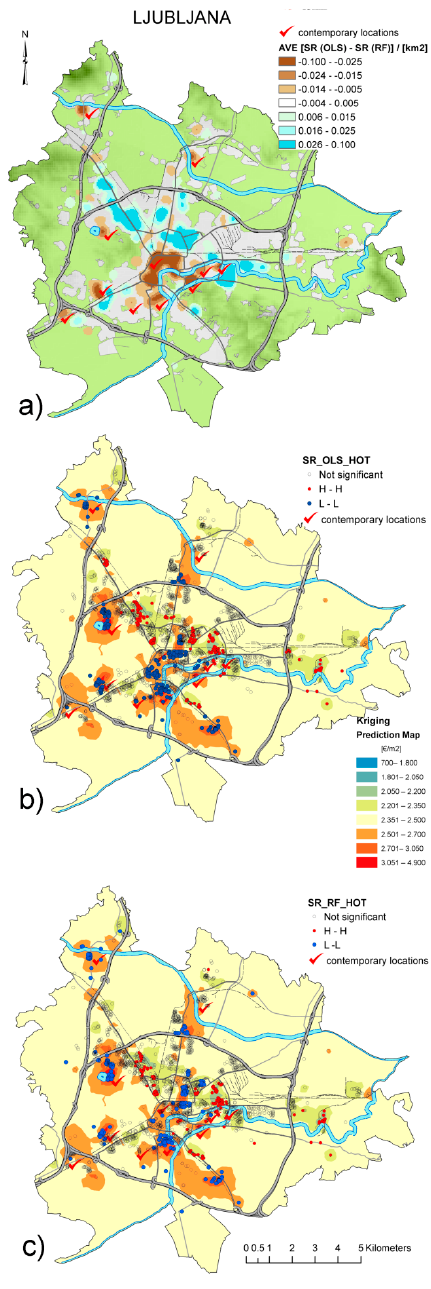
Figure 5. ( a ) Kernel density of the difference between sales ratios of OLS and RF; ( b ) Hot Spot Analysis of average sales ratio (SR)(OLS); ( c ) Hot Spot Analysis of average SR(RF).